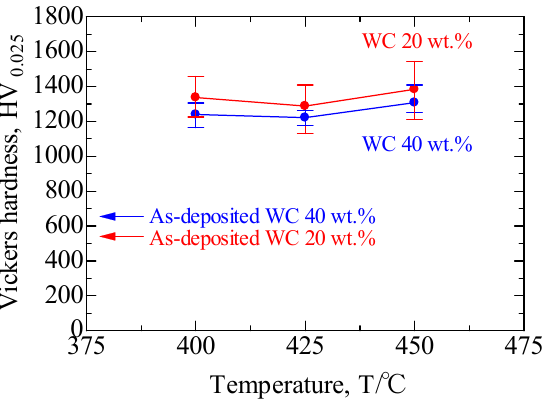
Figure 8. Vickers hardness of the surfaces of the as-deposited and nitrided layers with various WC compositions and nitriding temperatures.